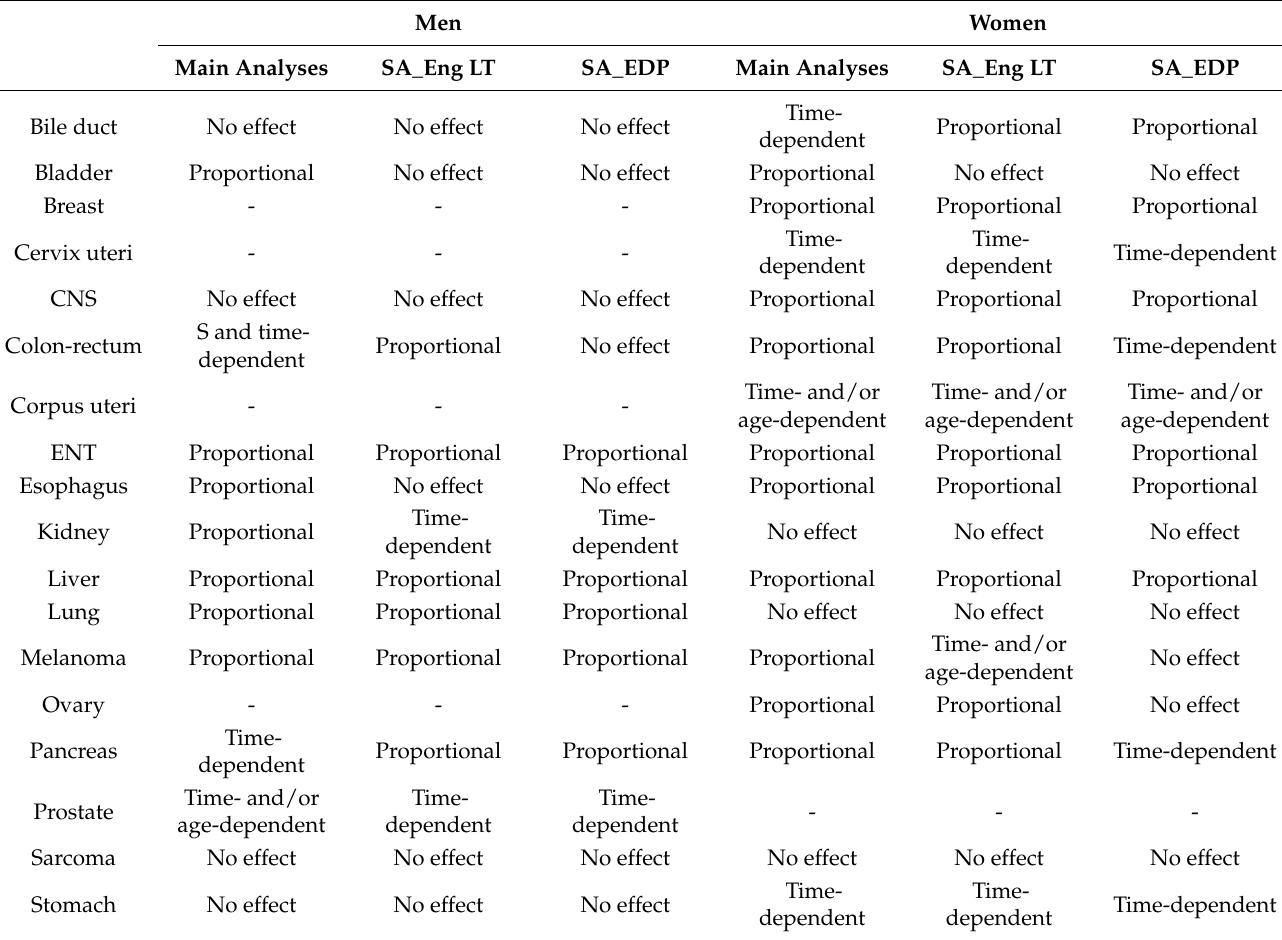
Table 1. The effect of deprivation (EDI) on cancer net survival for each cancer site, from the selected flexible model, according to main analyses, sensitivity analyses using English life tables (SA_Eng LT), and sensitivity analyses using EDP data